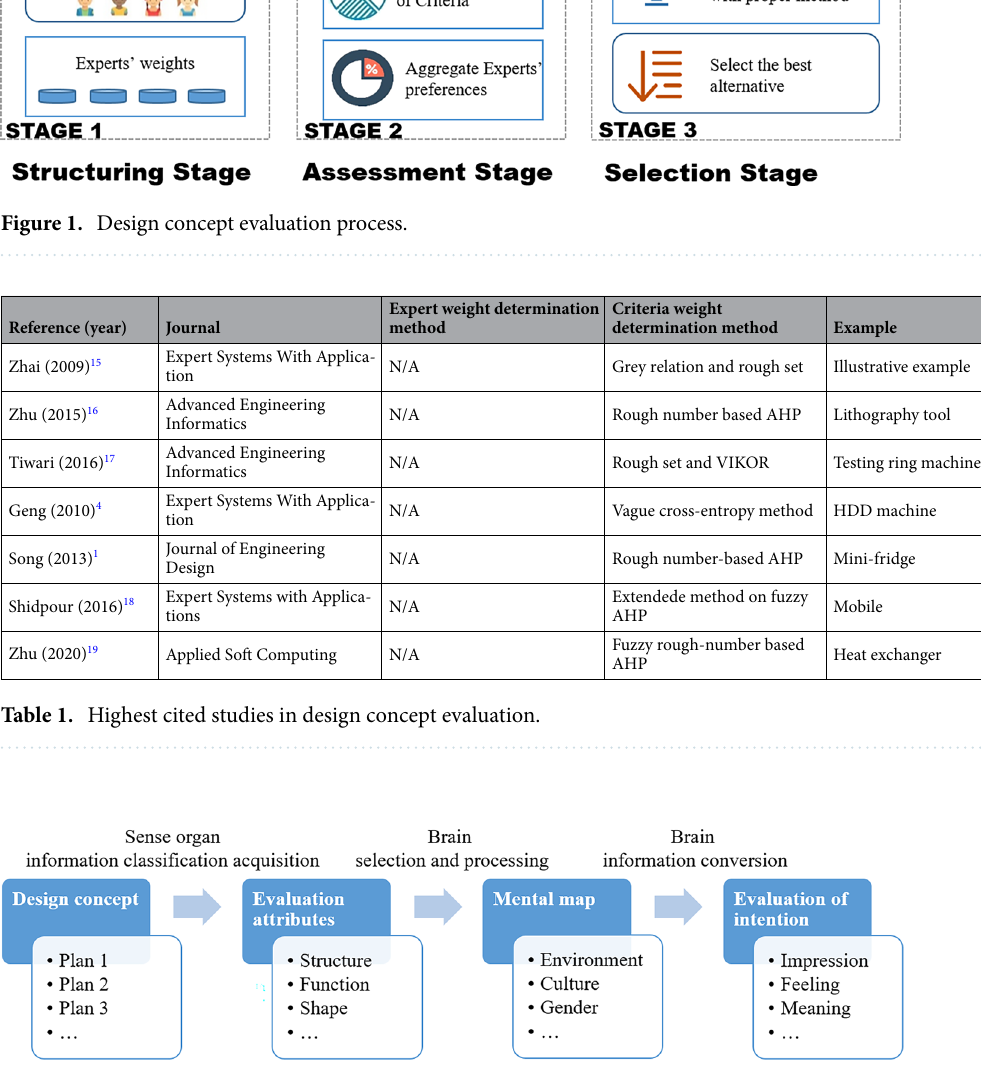
Figure 2. Cognitive system of design concept evaluation 20